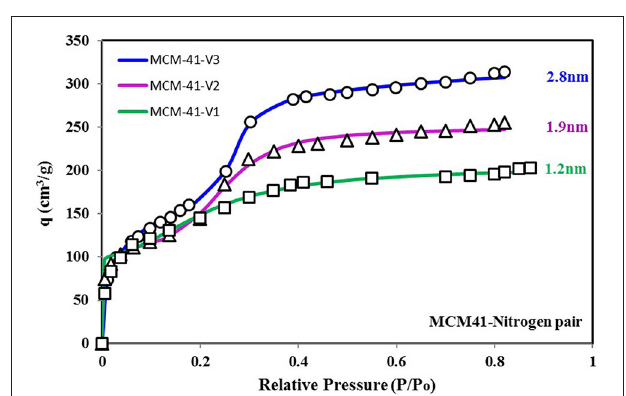
MCM-41 have the same distribution of adsorption energy sites.